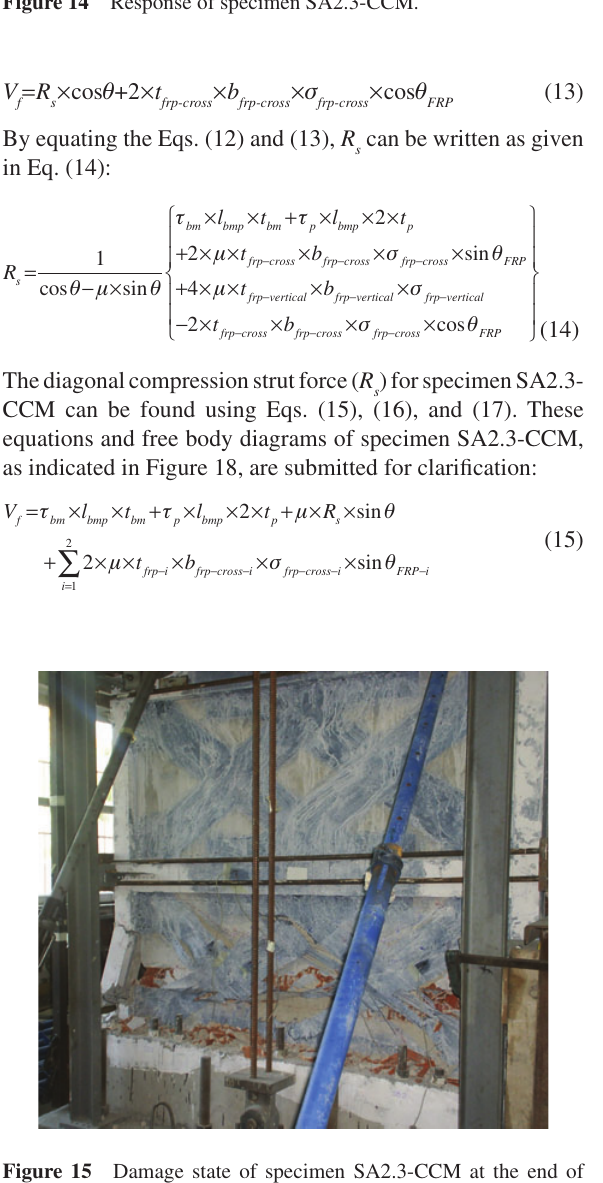
Figure 14 Response of specimen